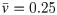
Time scales of learning.(A) Median gridness scores of the input synaptic weights for 40 random weight initializations and different learning-rate values, i.e., η = (2, 3, 5, 10) ⋅ 10−5. The weight development is simulated with the detailed spiking model with spatially-regular inputs and constant virtual-rat speed (see also Fig 5). (B) Median gridness scores of the input synaptic weights simulated with constant (black line) and variable (green line) virtual-rat speeds for 40 random weight initializations. Variable running speeds are obtained by sampling from an Ornstein-Uhlenbeck process with long-term mean v¯=0.25 m/s, volatility σv = 0.1 m ⋅ s−1.5 and mean-reversion speed θv = 10 s−1. The inset shows the distribution of running speeds (mean: 0.25 m/s std: 0.02 m/s). Note that the long-term mean v¯ of the process equals the speed v in constant-speed simulations. See Sec Numerical simulations for further details and additional parameter values.